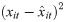
Log-likelihood of PLRNN and cross-validation performance of linear (LDS) and nonlinear (PLRNN) state space models on the ACC data.(A) Examples of log-likelihood curves across EM iterations from the 5/36 highest-likelihood runs for a 5-state PLRNN estimated from 19 simultaneously recorded prefrontal neurons on a working memory task (cf. Fig 9). State estimation here was performed by inverting only the single constraint corresponding to the largest deviation on each iteration (see Methods). (B) Cross-validation error (CVE) for the PLRNN (red curve) and the LDS (blue curve) as a function of the number of latent states M. CVE was assessed on each of 14 left-out trials with model parameters estimated from the remaining 14–1 = 13 experimental trials. Shown are squared errors (xit−x^it)2 averaged across all units i, time points t, and 40 different initial conditions. (C) Same as A, but with outputs x^it estimated from states predicted Δt = 1 (solid curves) or Δt = 3 (dashed curves) time steps ahead. Note that in this case the PLRNN consistently performs better than a LDS for all M, with the PLRNN-LDS difference growing as Δt increases. Error bars represent SEMs across those of the 40 initial conditions for which stable models were obtained (same for the means).